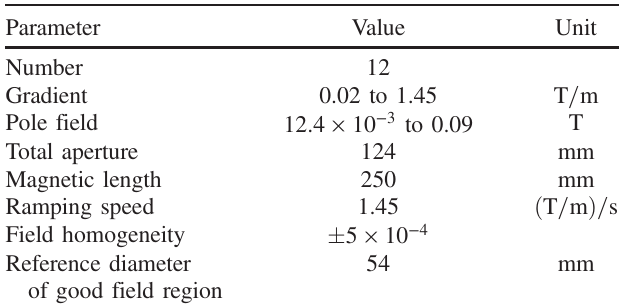
TABLE VII. Parameters of ELENA quadrupole